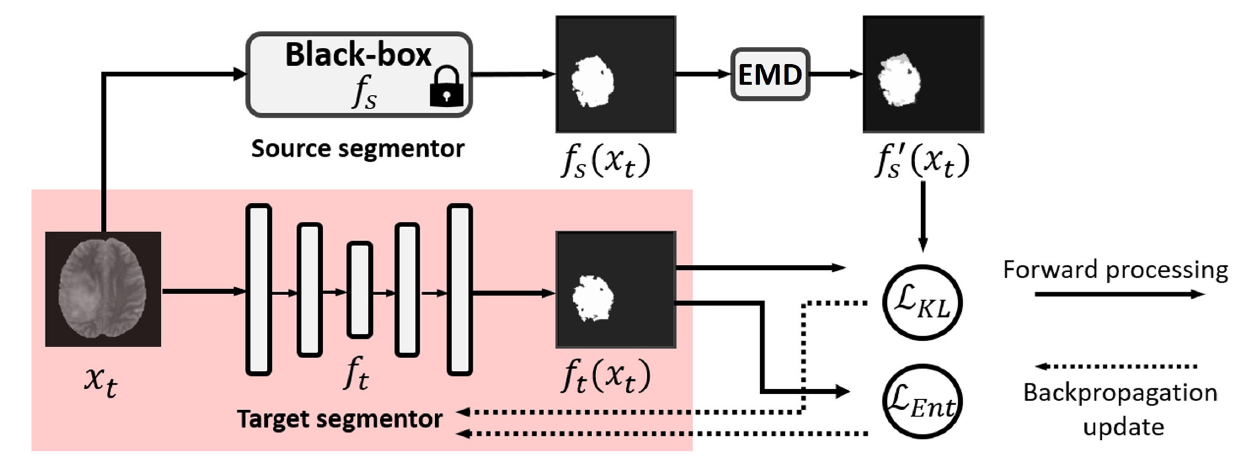
FIGURE 1 | Illustration of our black-box UDA framework using knowledge distillation with exponential mixup decay (EMD) pseudo label and unsupervised entropy minimization. Only the red shaded parts are used in testing in the target domain. Note that f s and f t can have different